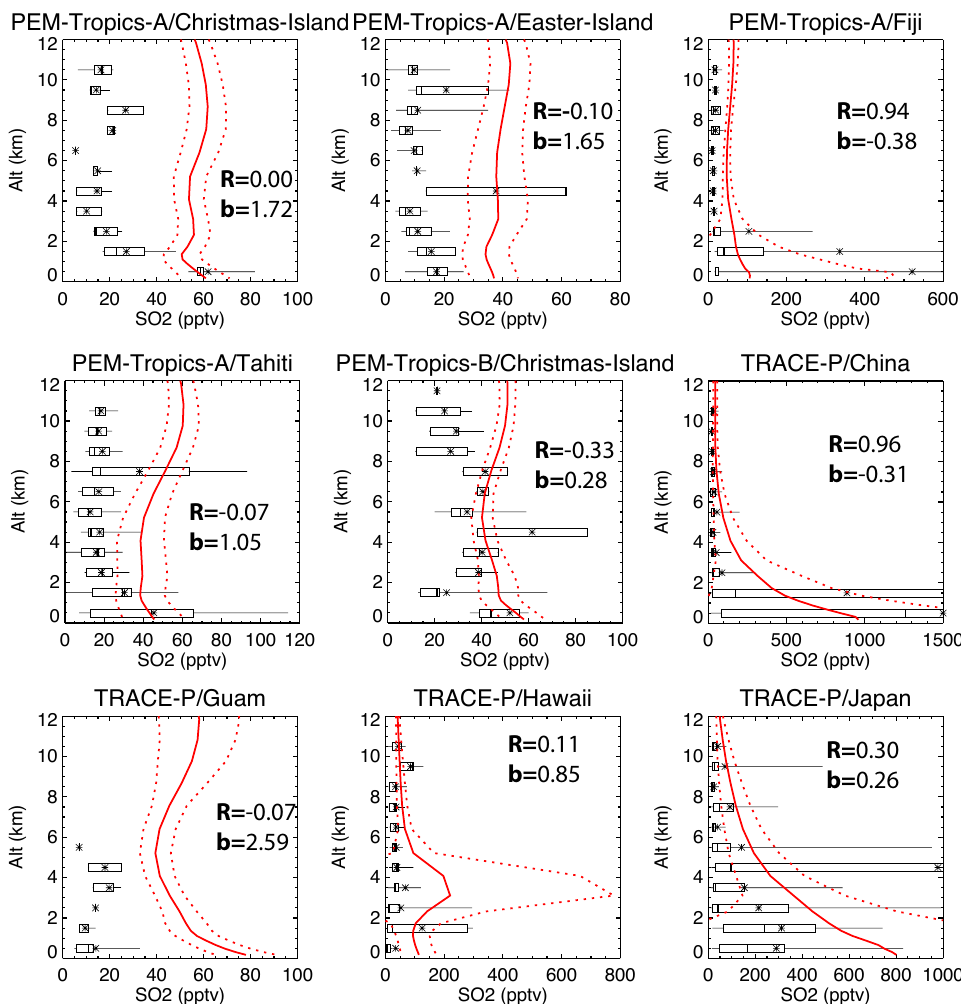
Fig. 8. The same as Fig. 7, but for SO 2 vertical profiles. lifetime is only slightly smaller than the AeroCom mean